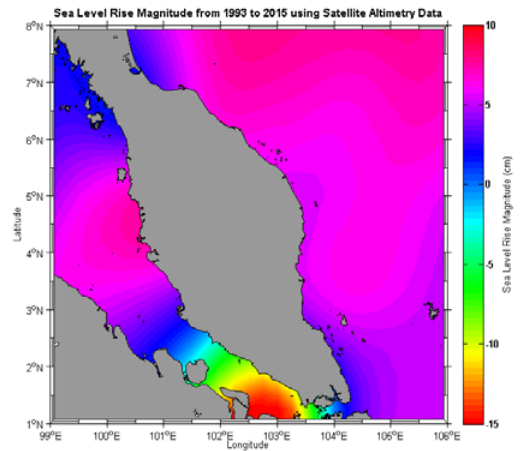
Figure 9. Map of sea level rise magnitude over Malacca Straits and South China Sea. The magnitude is computed from 23 years of altimetry data ranging from 1993 to 2015. Units are in cm.